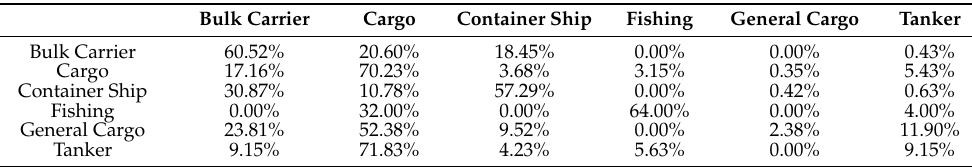
Table 8. The confusion matrix of SBNN in the six-categories Dual-Polarization SAR